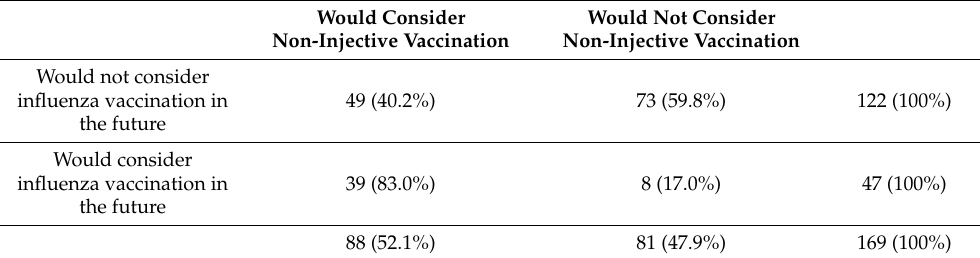
Table 4. Cross-table between “Influenza vaccination in the future” and “Would consider non-injective vaccination”